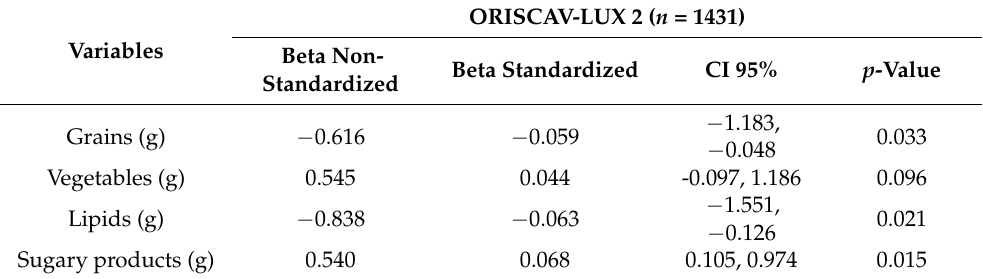
Table 6. Regression coefficients (beta, 95% CI) between food group intakes and constipation score based on linear regression modeling a .